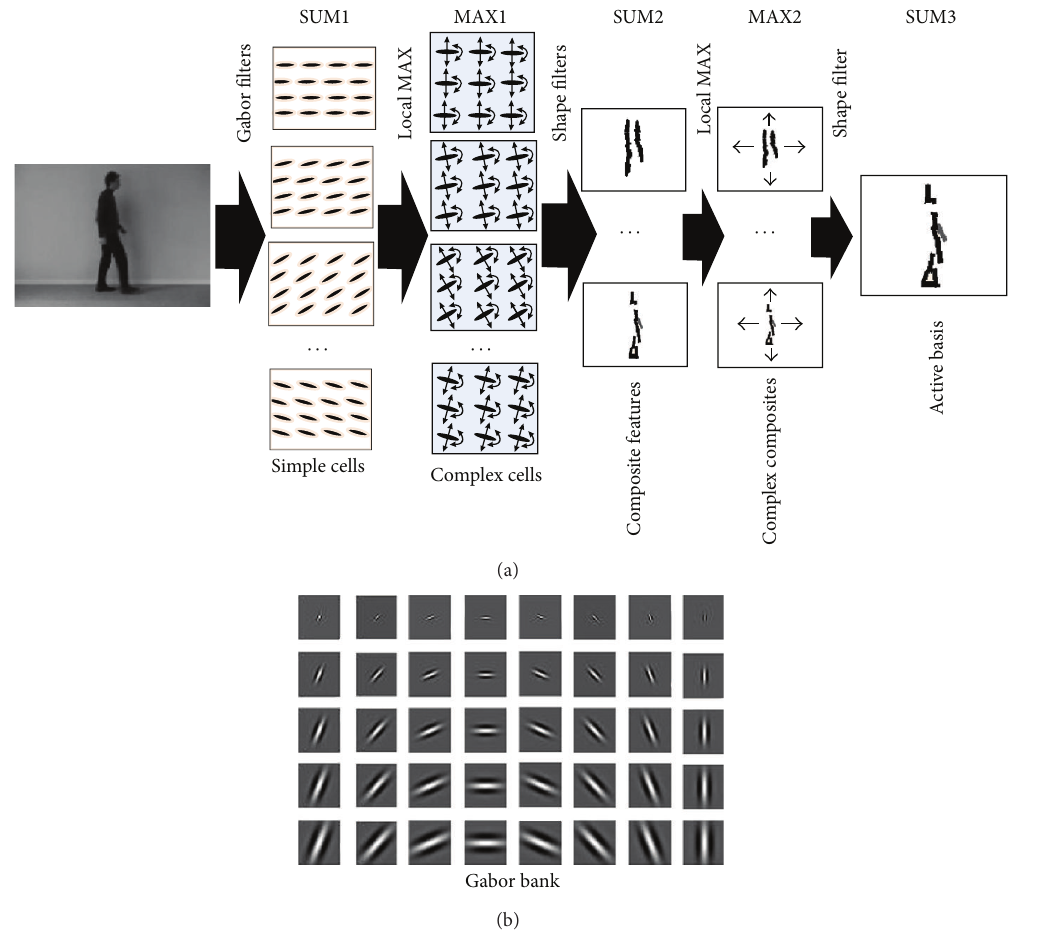
Figure 2: The explanation diagram of the ventral processing of the applying active basis model [24] which represents movements pattern and shape form of biological object within its movement episode. Active basis model is a Gabor based supervised object recognition method which can learn the object shape in the training stage and can be a utilized object recognizer within the action episode. (a) The processing digram of the ABM process for finding human object presented. The similarity between the method and biological finding in different level has been mentioned in different stages. (b) It represents the Gabor bank filter in different scales and orientations. Overall, ABM has two stages, SUM and MAX, which make the hierarchy from simple cells to complex cells and at the end whole human object shape by active